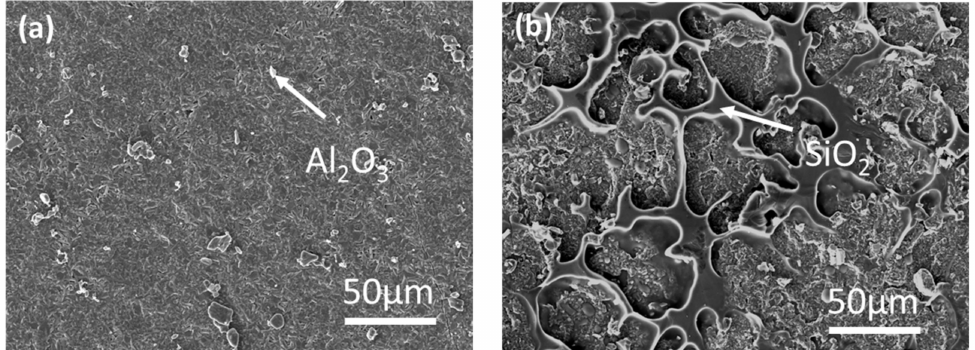
Figure 2. SE image of surface morphologies of B modified silicides coatings prepared with Al 2 O 3 ( a ) and SiO 2 ( b